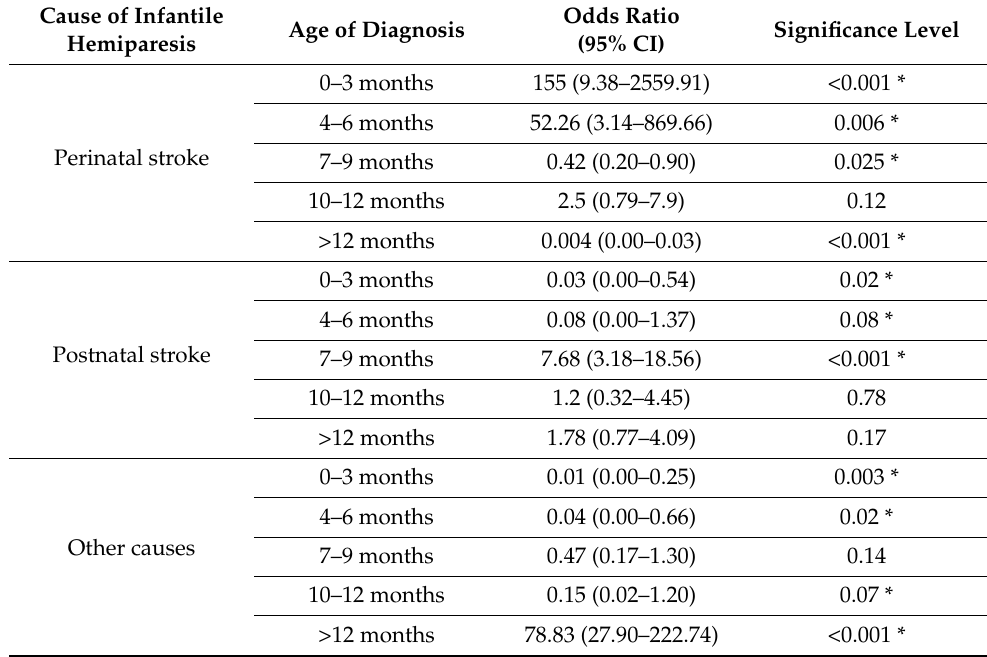
Table 5. Association between the cause of infantile hemiparesis and age of diagnosis. Cause of Infantile